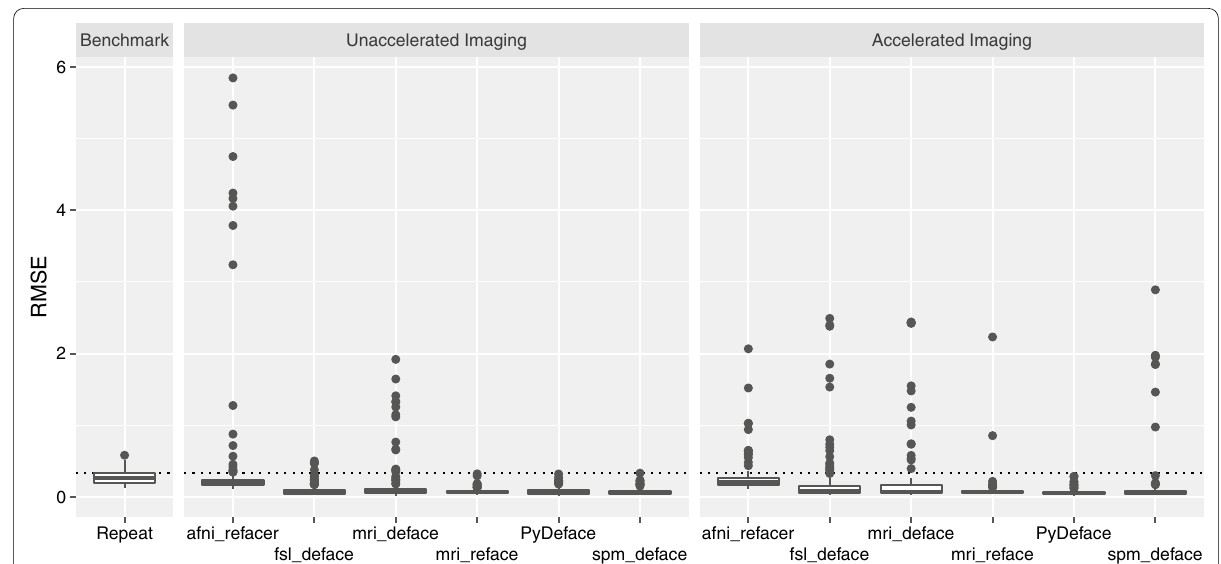
Fig. 2 Box-and-whisker plots of the root-mean-square error (RMSE) values after veganbagel processing of Alzheimer’s disease patients. Left column: The benchmark result obtained by calculating the RMSE between gray matter z-scores of full face unaccelerated 3D T1 imaging and the respective same-session unaccelerated repeat 3D T1 imaging. Center and right: RMSE values obtained by comparing z-scores of defaced unaccelerated (center) or accelerated (right) 3D T1 imaging series with the respective full face 3D T1 imaging. The dotted black line denotes the 75th percentile of the RMSE values of the